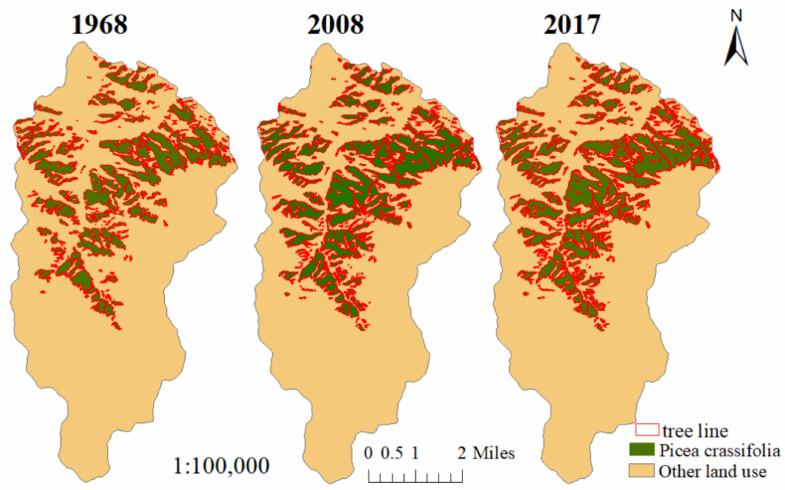
Figure 4. Distribution of Picea crassifolia Kom. in the Dayekou watershed in di ff erent years. The spatial distribution change of Picea crassifolia Kom. forest area from 1968 to 2017 is shown in Figure 5. Between 1968 and 2008, patch areas that remained unchanged accounted for 92.14% of the total area of the watershed. During that time, the ratio of Picea crassifolia Kom. area to non- Picea crassifolia Kom. area was 2.24%, while conversion of areas from non- Picea crassifolia Kom. to Picea crassifolia Kom. reached